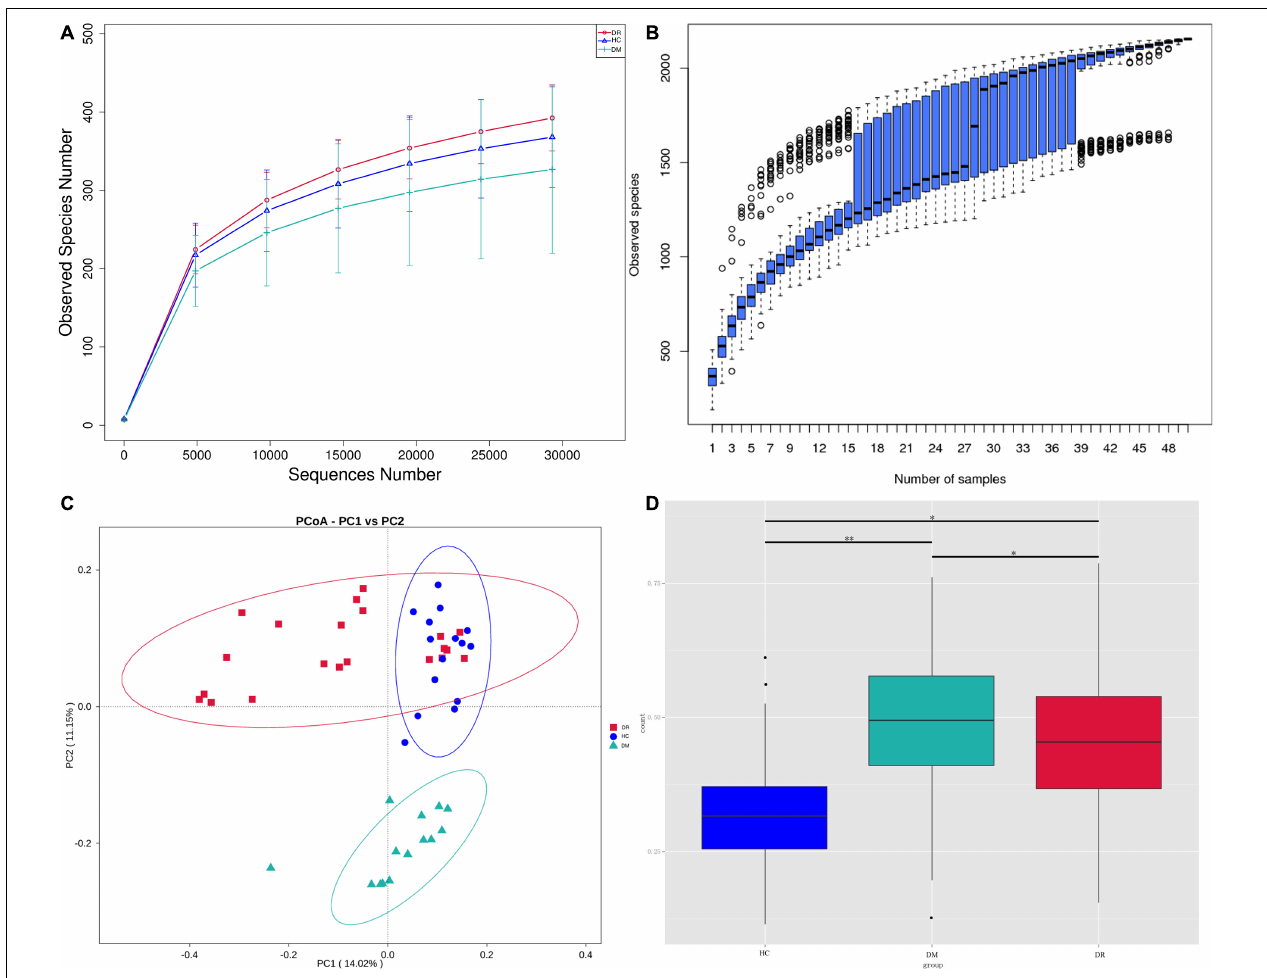
FIGURE 1 | (A) Reflectance curve based on OTU count in healthy control group, DR patients and DM patients. DR, DR patients (orange); HC, healthy people (blue); DM, DM patients (green). (B) The horizontal coordinate is the sample size; the vertical coordinate is the number of OTUs after sampling. (C) The PCoA ordination of Bray-Curtis distances among DR patients, DM patients and healthy controls from 16S rDNA sequencing data. The first three axes of PCoA showed a clear separation. (D) Beta diversity between-group difference box plots are based on weighted unifrac distances for the multi-group non-parametric wilcox test. ∗ p < 0.05, ∗∗ p <